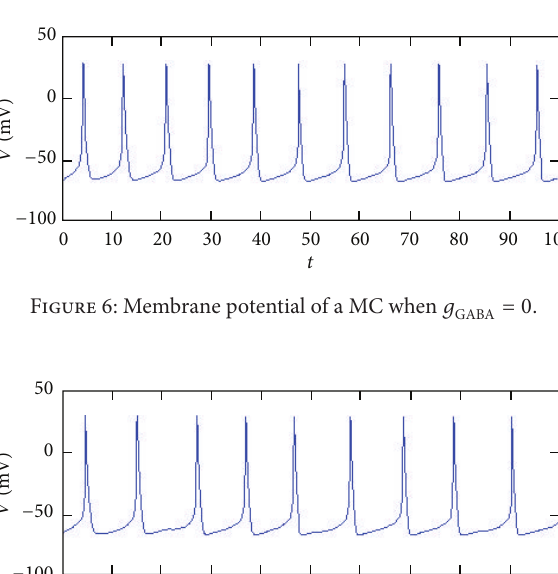
Figure 5: Membrane potential of a GC when 𝑔